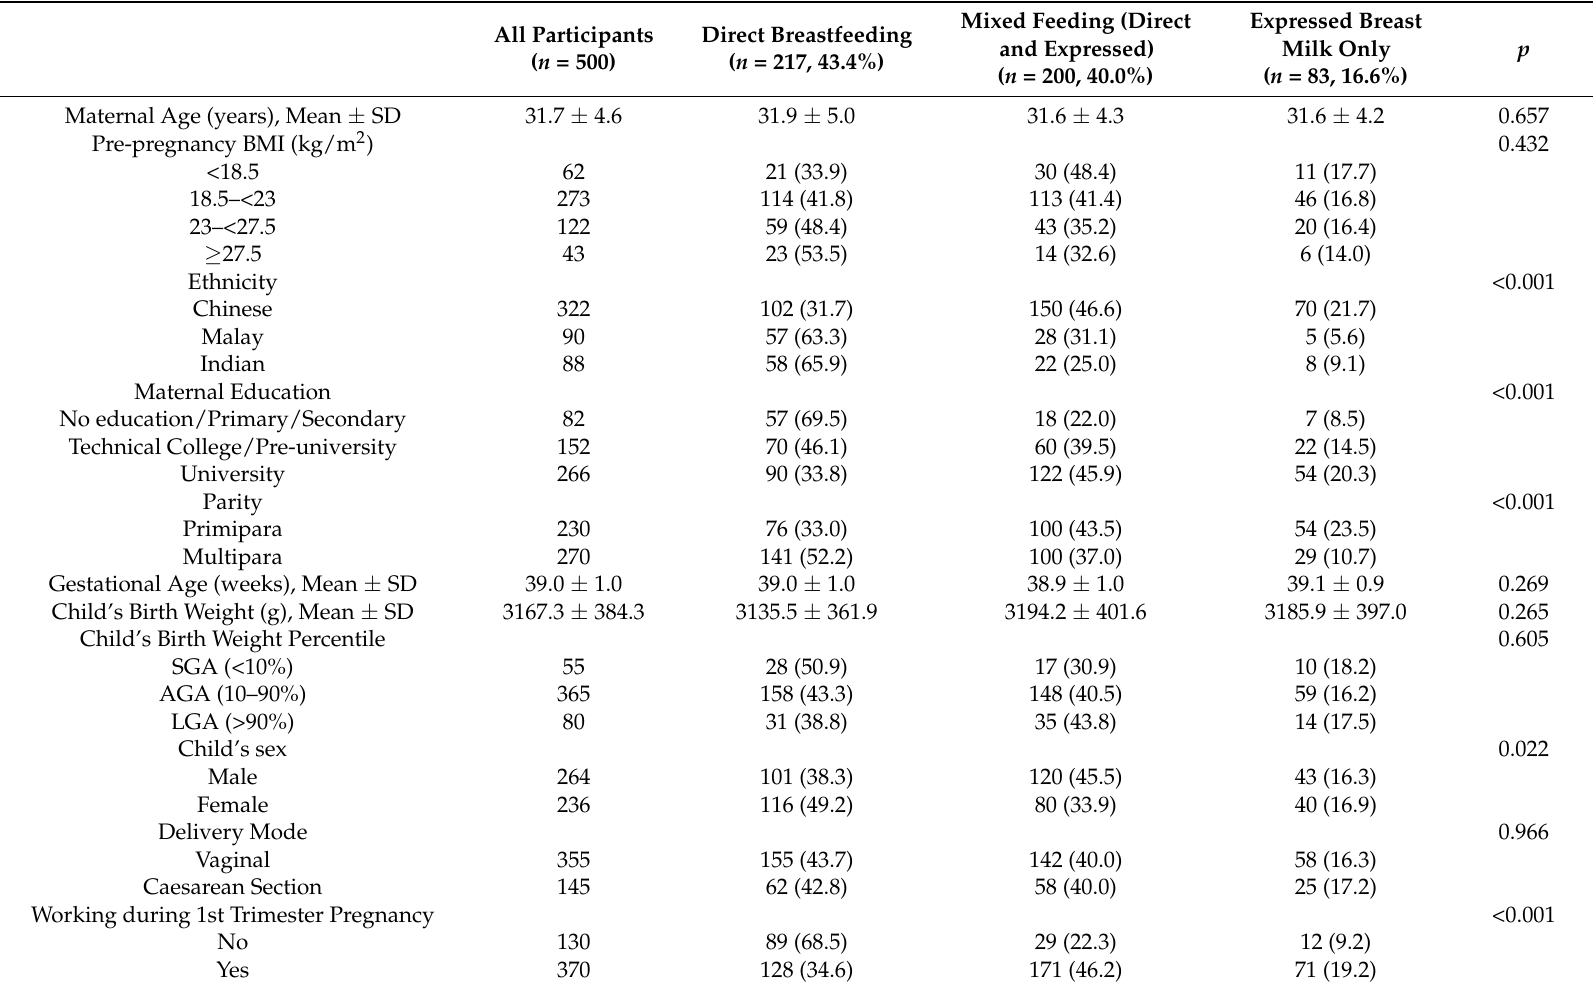
Table 1. Characteristics and breastfeeding practices reported at three weeks among mothers practicing different breastfeeding modes at three months postpartum ( n = 500) 1